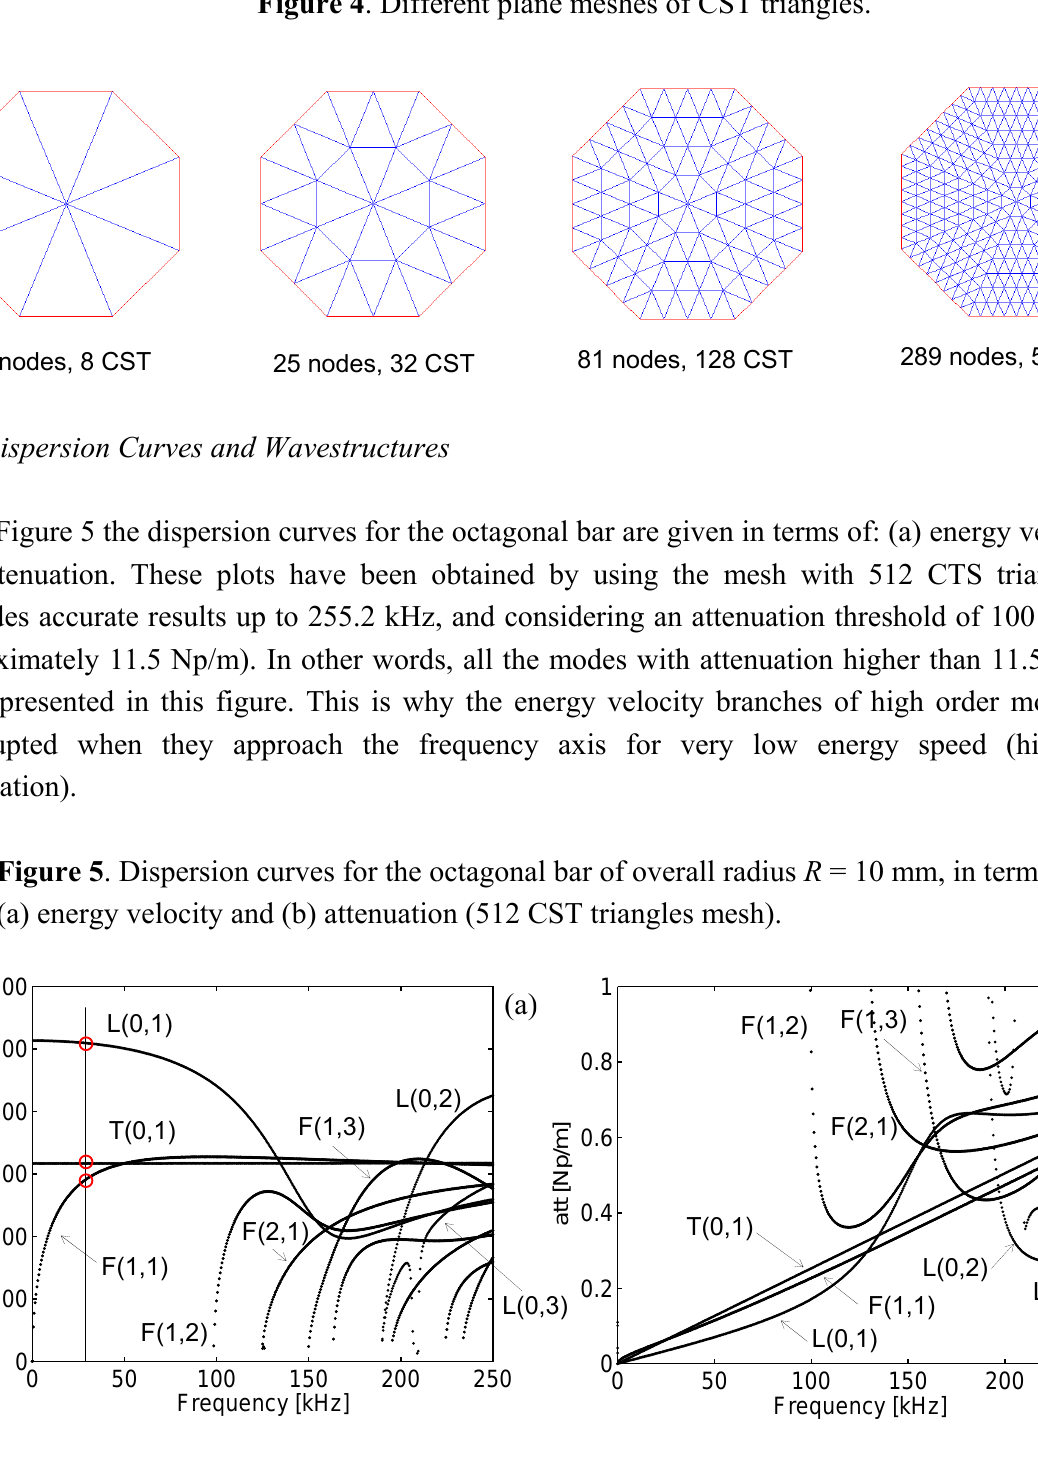
Figure 4 . Different plane meshes of CST triangles.